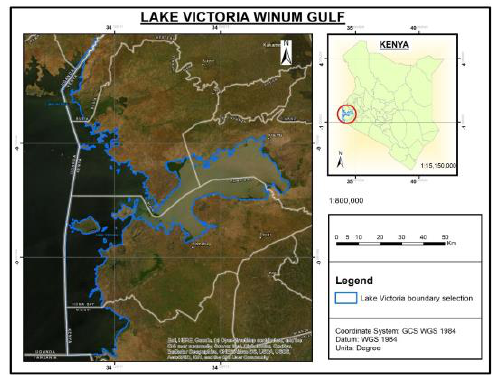
Figure 1 : The figure above shows Lake Victoria around Winum Gulf, the Kenyan coast next to Kisumu metropolitan area. The imagery was later taken through masking of the area of study using the available geometry after the resultant imagery was geo-referenced and co- registered correctly in space. The imagery underwent conversion to radiance applying the level 1 digital number as conversion matrix. Solar correction was paramount in getting rid of top of atmospheric reflectance after which the resultant imagery was in form of surface reflectance and outputted as image composite of the resultant Near Infrared Band, Red and Green bands. The composite resultant clipped image was later cloud masked to less than 10 percent of using mono temporal standard approaches, which leads to 4-5 percent in classification accuracy and 3-10 percentage in commission errors (Mateo-Garcia et al., 2020). The resultant image was then enhanced using histogram equalization to improve the quality of the scene. The available imagery in first half of January was averaged to yield one layer of